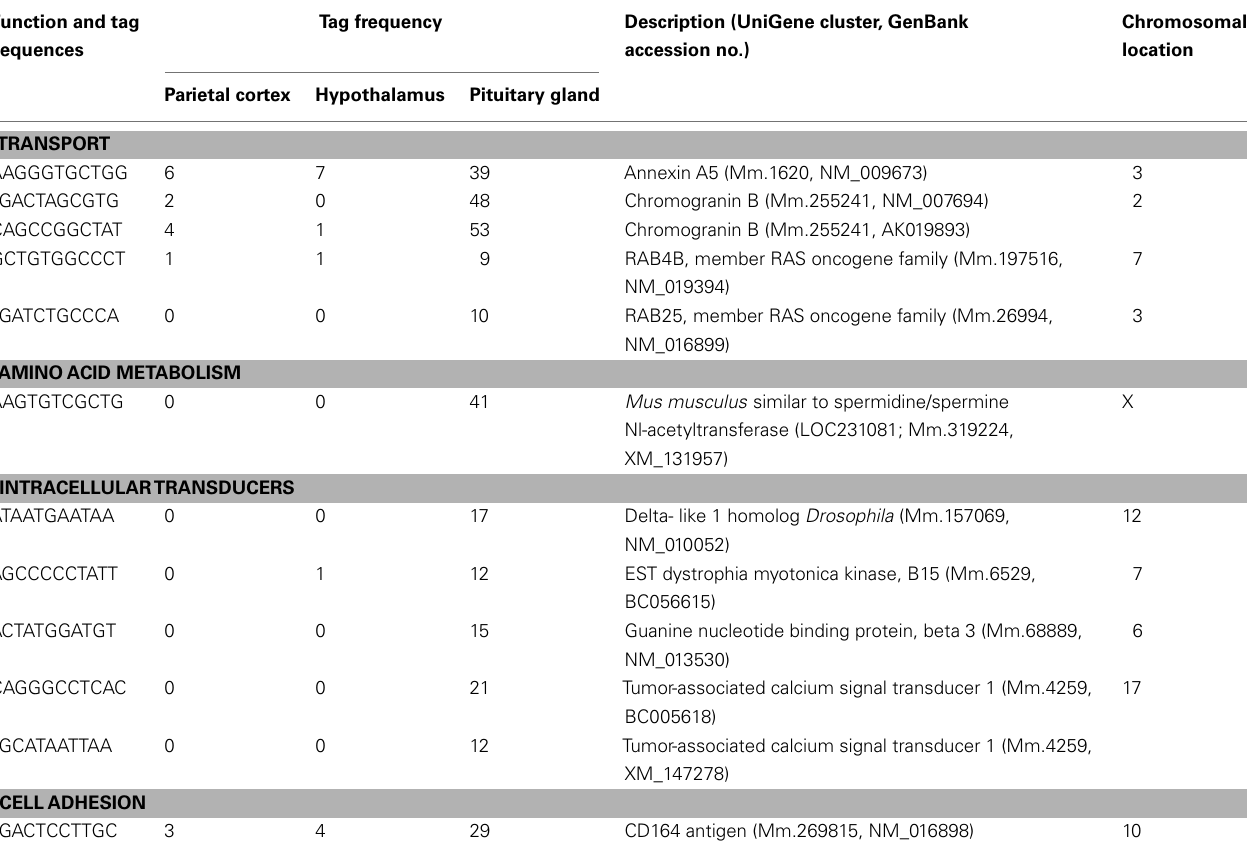
Table 4 | Components of the metabolism and cell signaling/communication preferentially expressed in pituitary gland. Function and